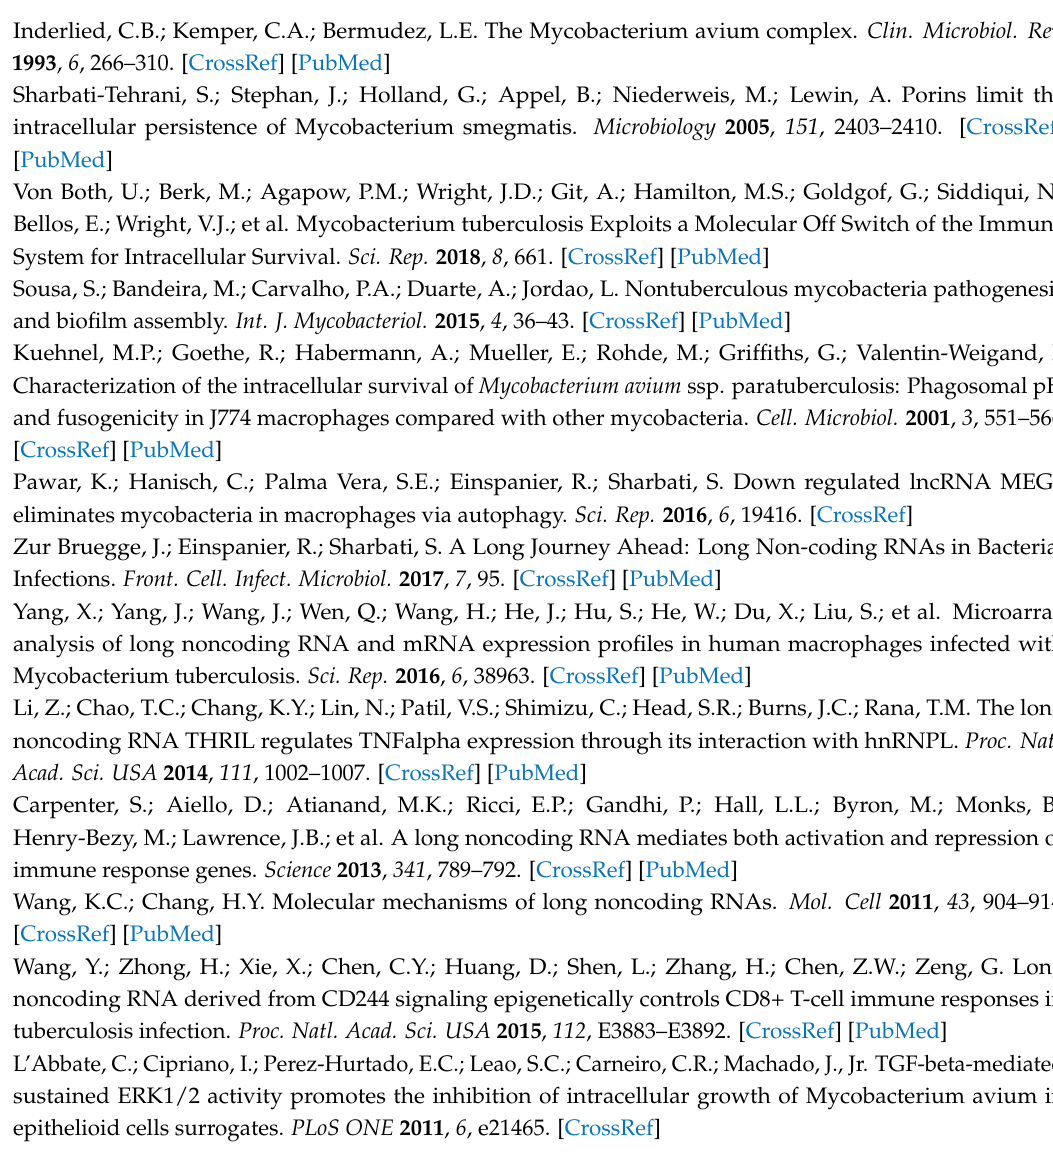
Figure A1. Stable expression of reference genes ( B2M , GAPDH , and SDHA ) after infection with M. smegmatis (MS) or M. avium subsp. hominissuis (MAH). The fold difference to the negative control (NC) is shown. Columns show means of three biological replicates ( n = 3) and bars show the standard deviation.